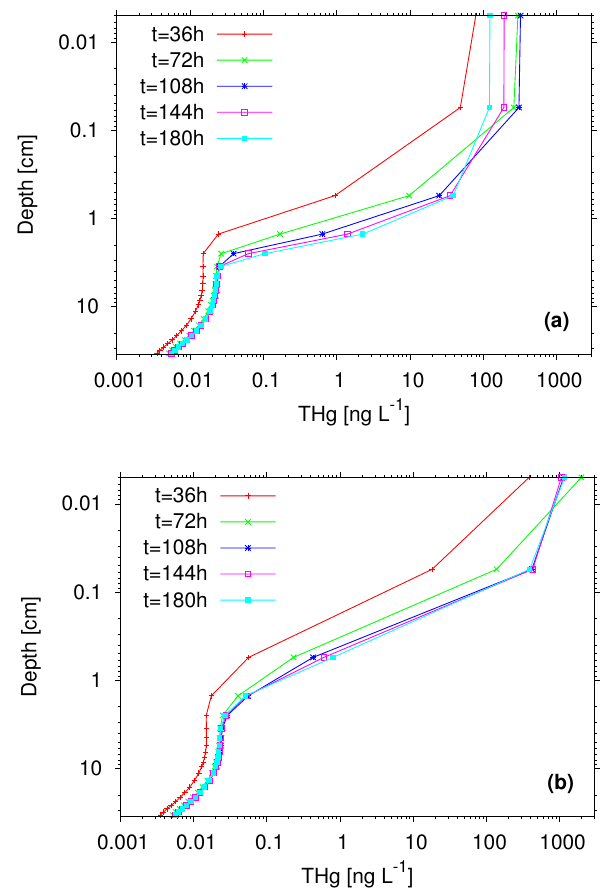
Fig. 14. Concentration profiles of total dissolved mercury as simulated in the model run employing scenario 1A at U 2 = 4 . 5 m s − 1 : (a) the base case with vertical diffusion through the LLL network in the snowpack and (b) the case without vertical diffusion through the LLL network.